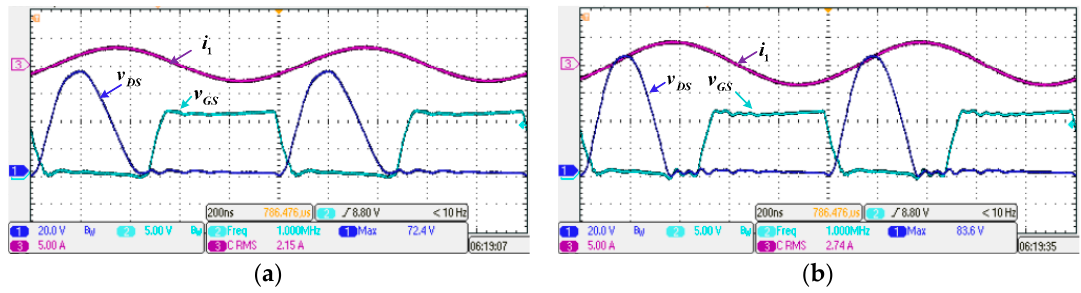
Figure 16. Waveforms of driver signal v GS , transmitter current i 1 , and drain-to-source voltage v DS , when iron plate at line l 1 . ( a ) d 1 = 15 cm; ( b ) d 1 = 5 cm.